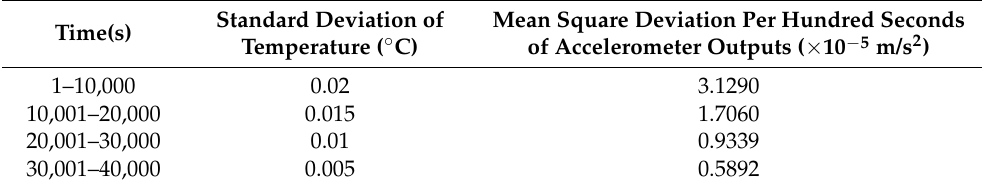
Table 2. Test results of different temperature variation.